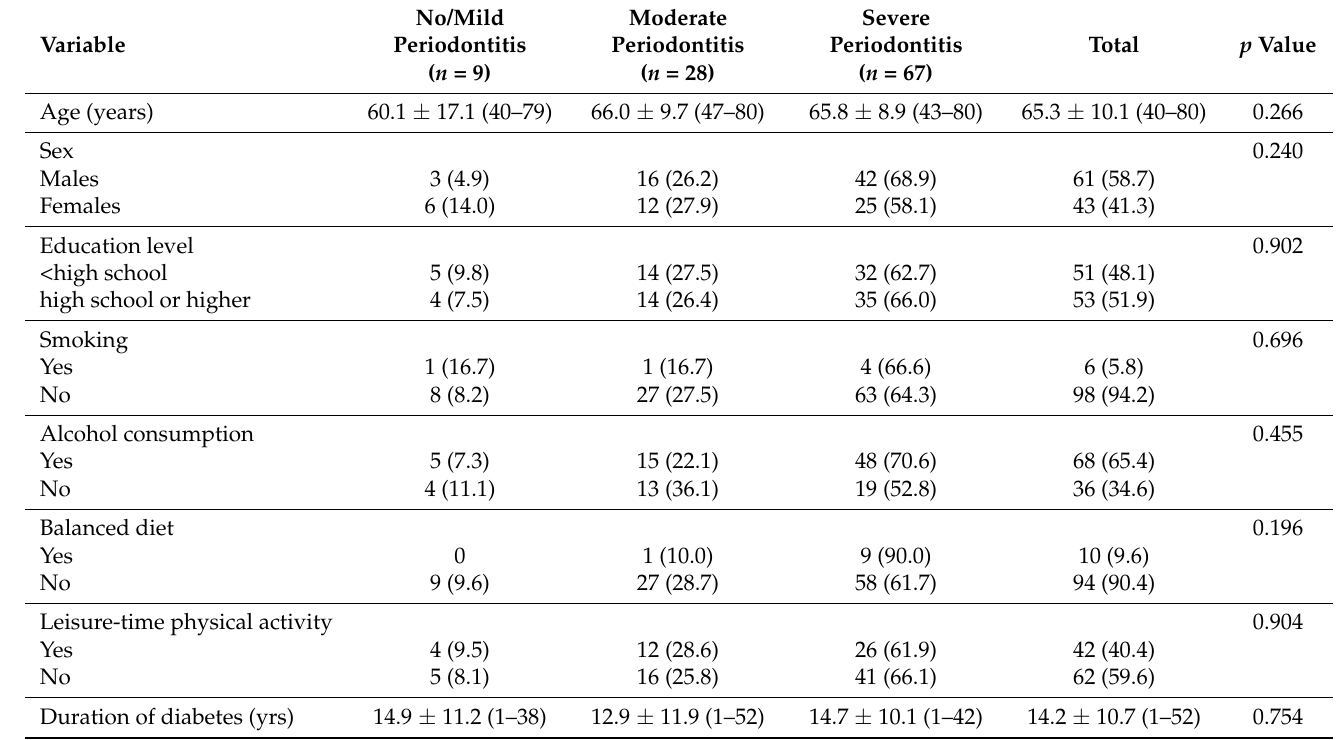
Table 2. Sociodemographic and clinical characteristics of T2DM patients (mean ± SD (range) or n (%)) according to the periodontal